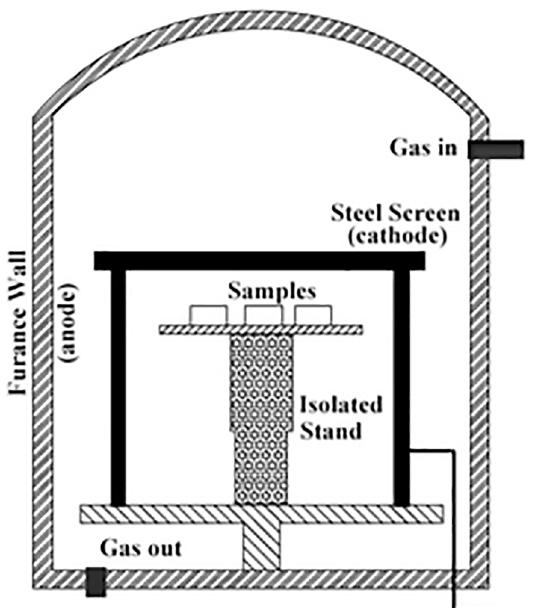
Figure 1. Schematic diagram of the main components of the active screen plasma